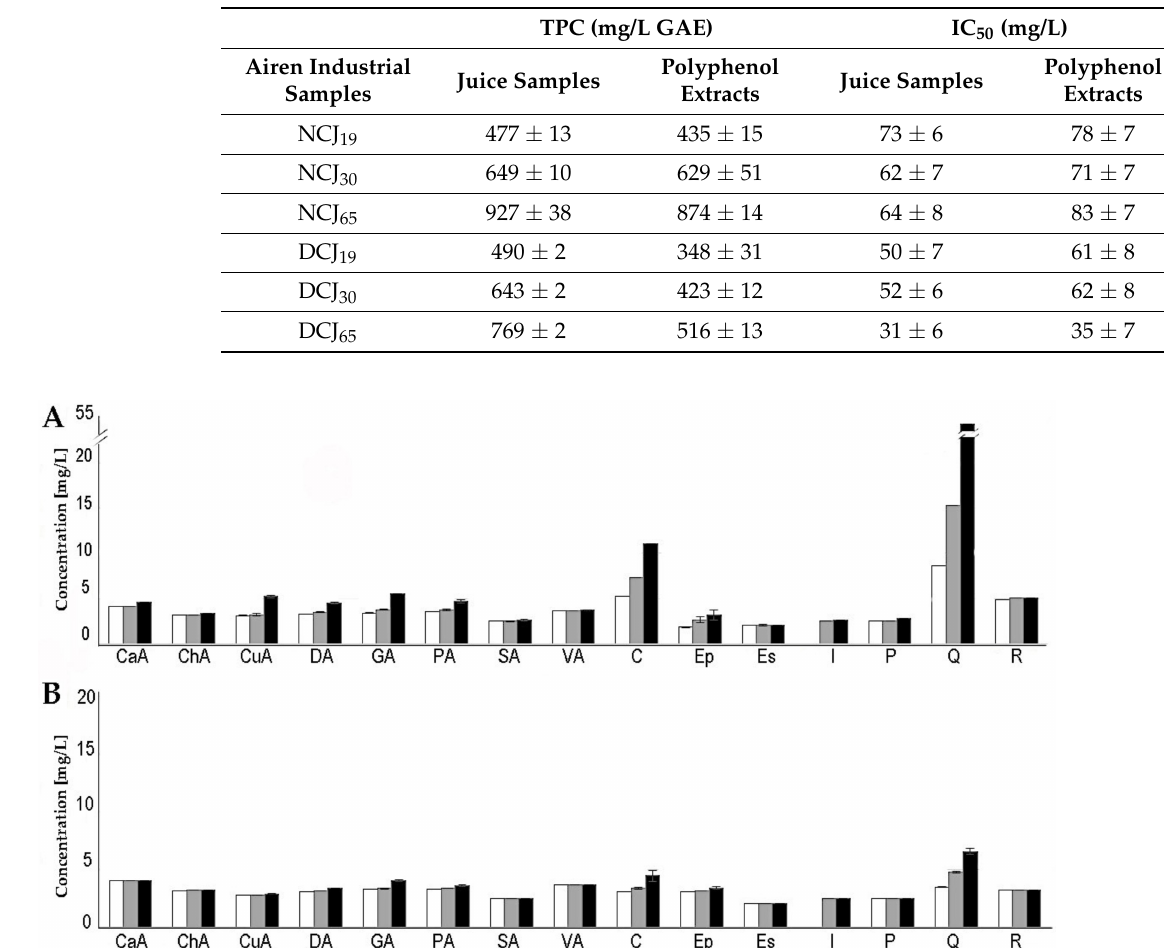
Figure 3. Concentration of the 15 polyphenols identified by LC-MS/MS in the Airen industrial grape juice samples at 19 ◦ Bx ). ( A ). Normal concentrated grape juice samples (NCJ). ( B ). Decolorized concentrated